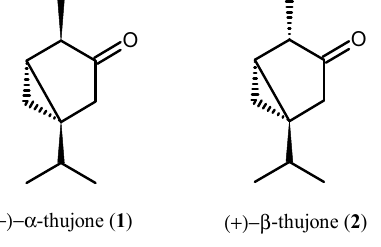
Figure 1. Diastereoisomers of